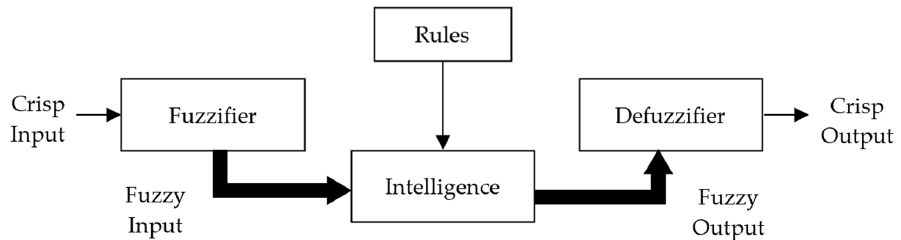
Figure 1. The components of a fuzzy logic system (FLS).